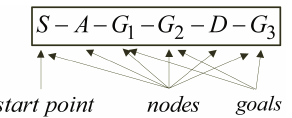
Fig. 5. An example of